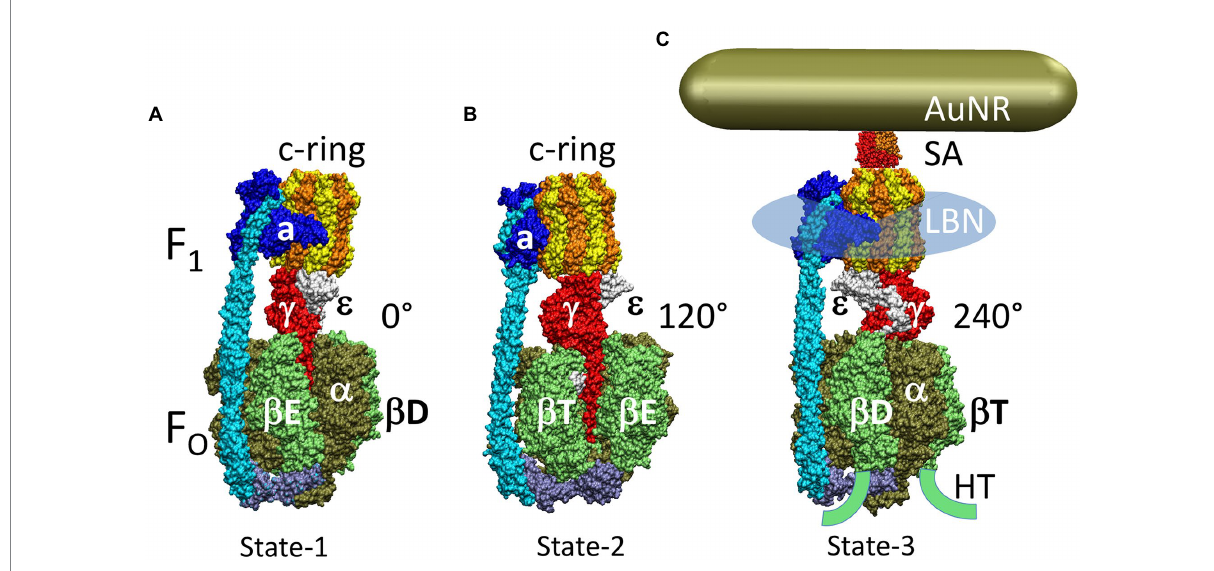
FIGURE 11 Cryo-EM structures of the three rotary states of Ec F 1 F O ATP synthase inhibited by ADP. (A) State-1 E cF 1 F O structure 6OQU. (B) State-2, E cF 1 F O structure 6OQV with rotor 120 ° CCW from A where subunit- α is not shown to reveal subunit– γ . (C) State-3 E cF 1 F O structure 6WNR with rotor 240 ° CCW from A showing microscope slide assembly of F 1 F O embedded in a lipid bilayer nanodisk (LBN) for rotation measurements. His 6 -tags (HT) on β -subunit C-termini enabled attachment to slide, while the AuNR coated with streptavidin (SA) bound to the biotinylated subunit-c ring. This figure was modified from Yanagisawa and Frasch,